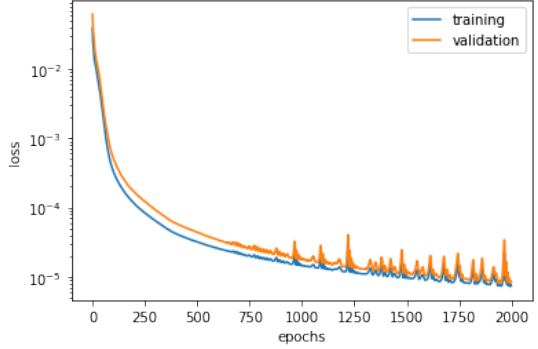
Figure 6. Decrease in loss function over 2000 epochs.